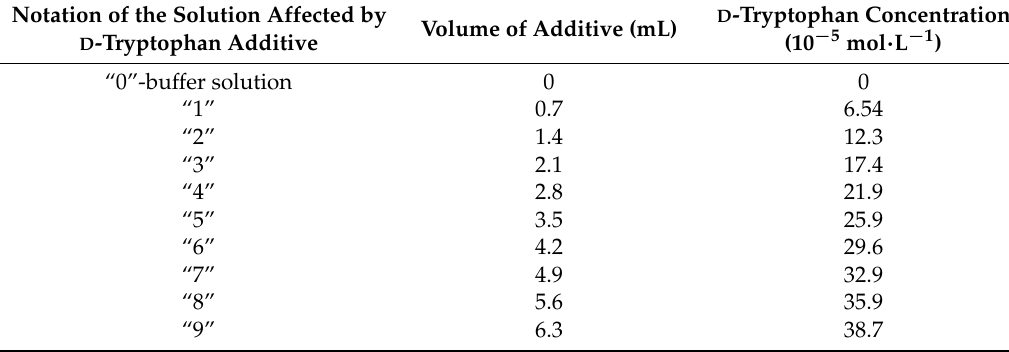
Table 2. The values of D -tryptophan added in the given buffer solute (the phosphate buffer solution (Na 2 HPO 4 + KH 2 PO 4 ) with pH